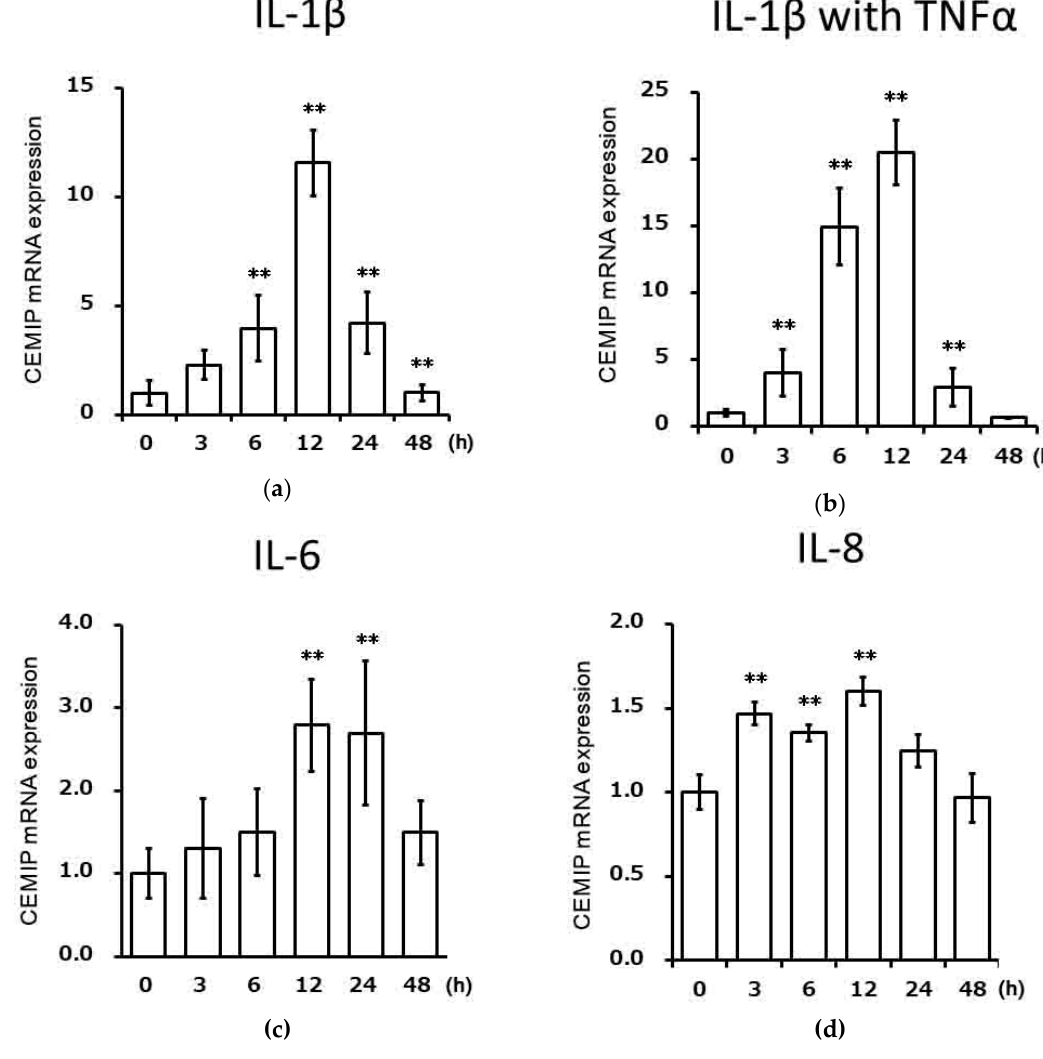
Figure 2. CEMIP mRNA induction by various cytokines. OUMS-27 cells were stimulated with cytokines for various durations (hours) as indicated. ( a ) Cells were treated with 10 ng/mL IL-1 β . ( b ) Cells were treated with two cytokines, IL-1 β and TNF α (each 10 ng/mL). ( c ) Cells were treated with IL-6 and soluble IL-6 receptor (each 50 ng/mL). ( d ) Cells were treated with IL-8 (100 ng/mL). Levels of CEMIP mRNA were measured relative to the levels of mRNA found in the unstimulated control cells. Values represent mean ± SD ( n = 6 per group). ** p < 0.01 vs. control.